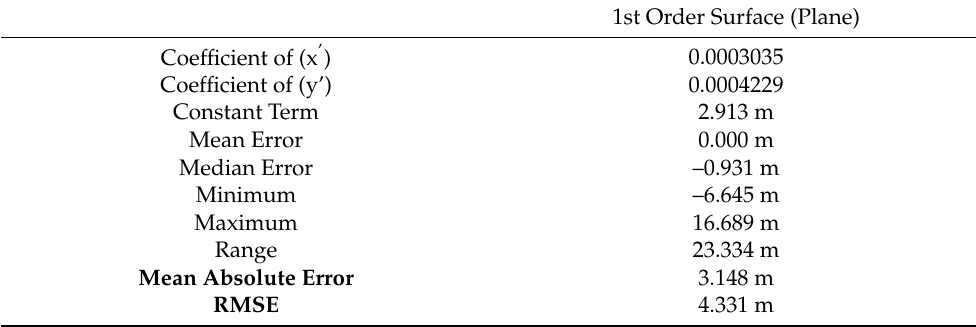
Table 6. Results and statistics for surface fits for ( h DTM − h SONAR ).